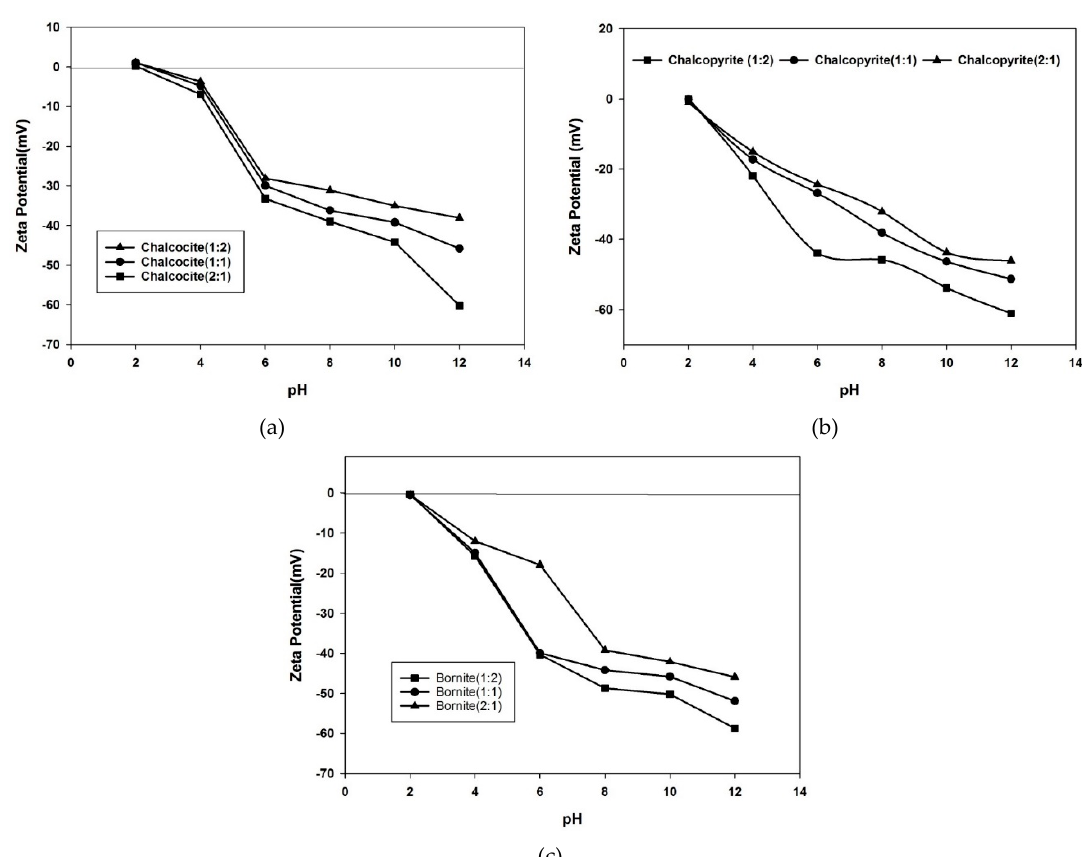
Figure 6. The zeta potentials of ( a ) chalcopyrite, ( b ) chalcocite, and ( c ) bornite as a function of pH in presence of collector mixture (SIBX:DBD).